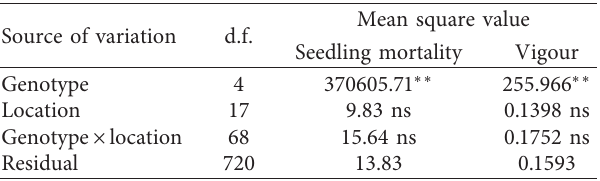
Table 2: Combined analysis of variance for five genotypes across 18 locations.